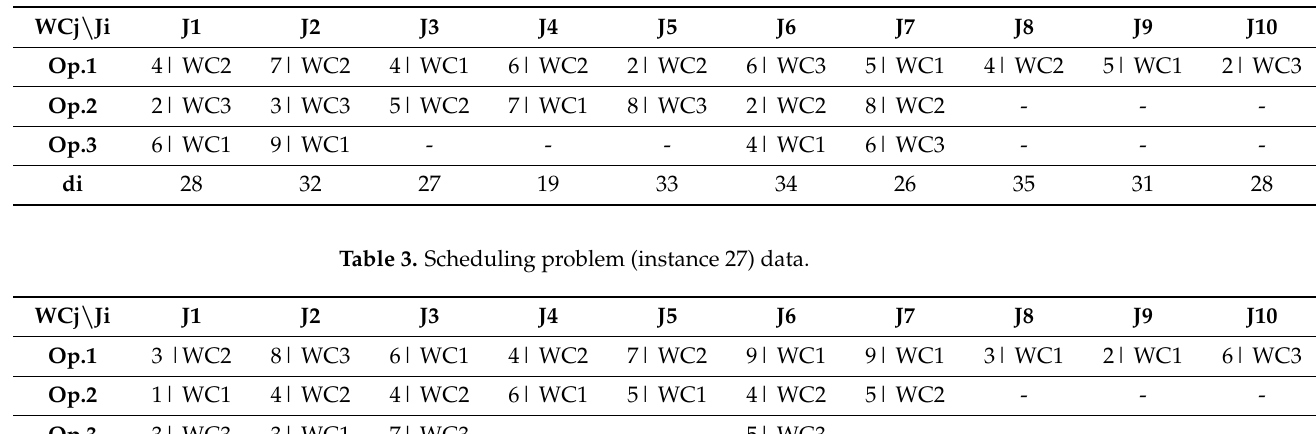
Table 2. Scheduling problem (instance 5) data.